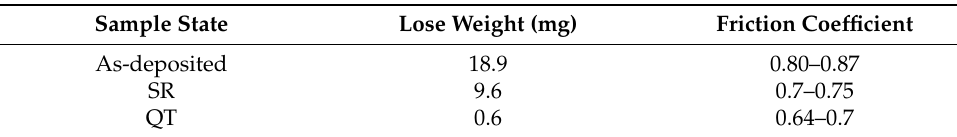
Table 5. High-temperature friction and wear performance test results.